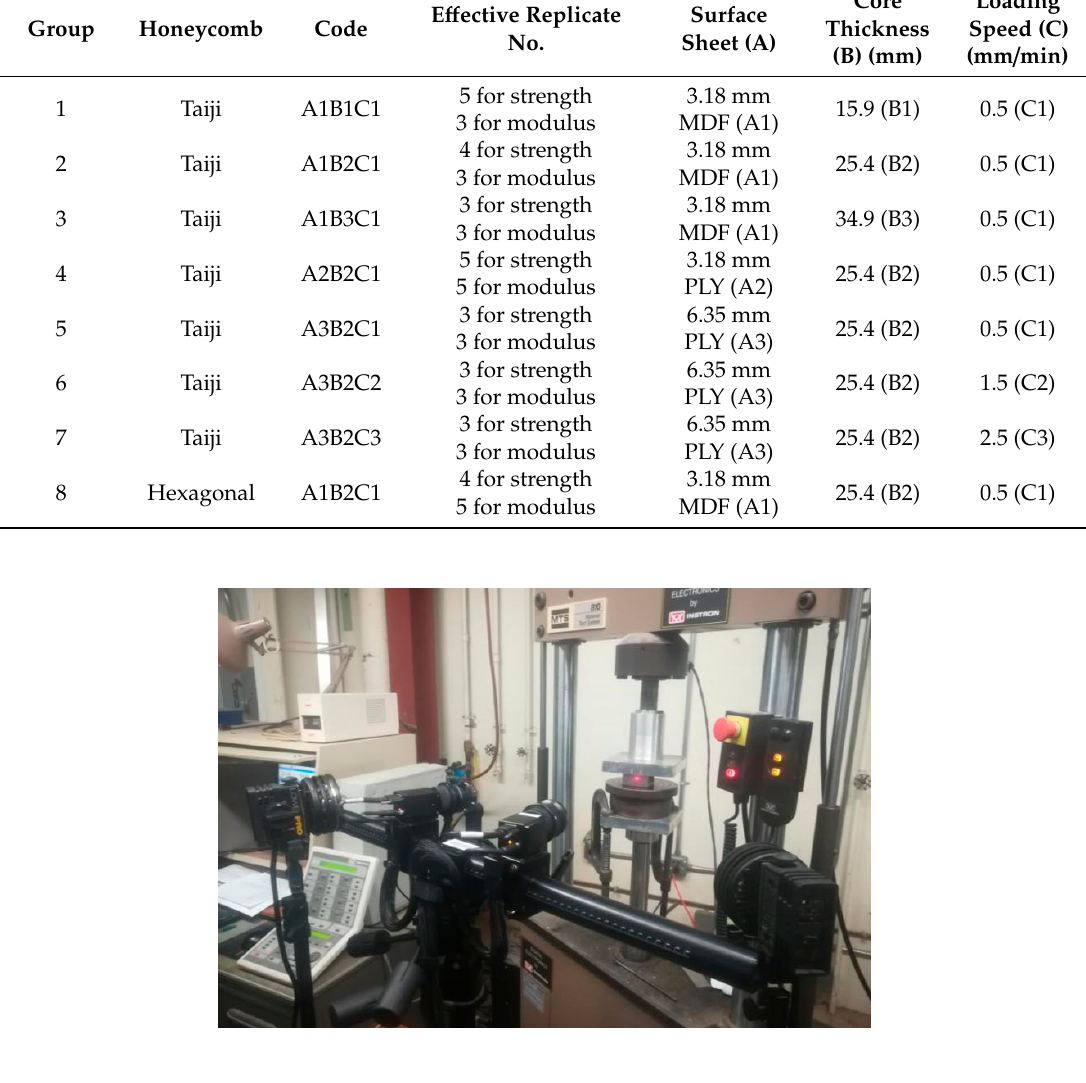
Table 3. Experimental combinations of the sandwich beam structure parameters.